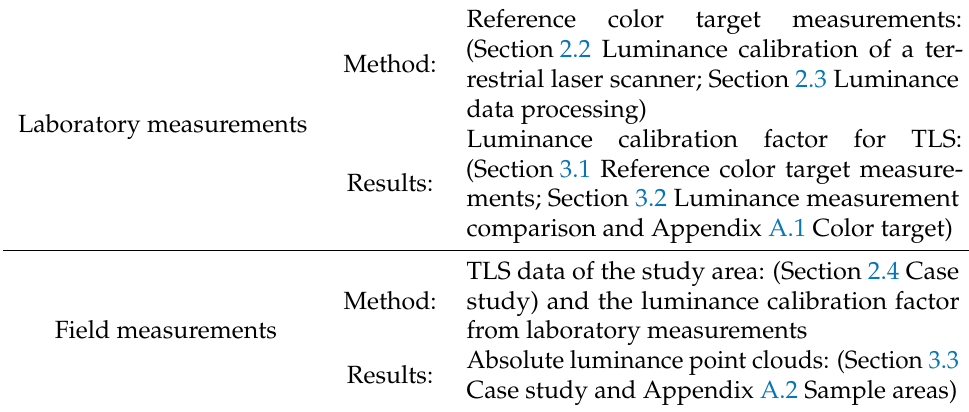
Table 1. Measurements and results performed in the study and their sections.